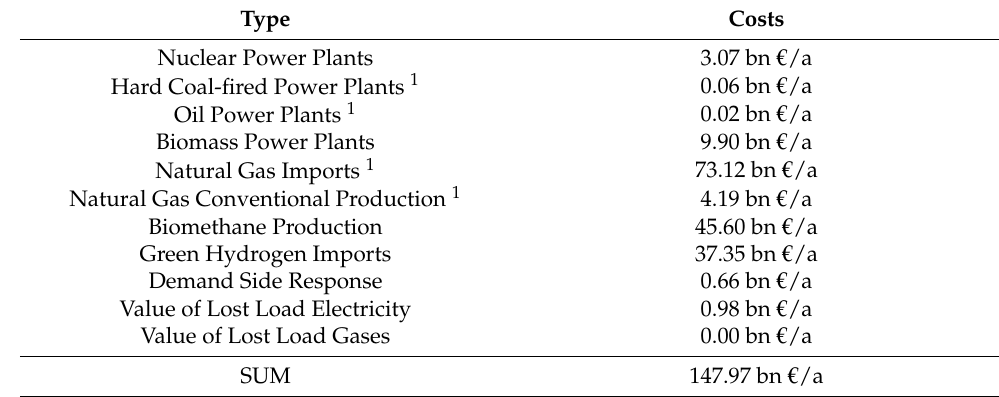
Figure 3. Considered infrastructure models: power plant fleet ( top left ), electric transmission system ( top right ), hydrogen transmission system ( bottom left ), natural gas (methane) transmission system ( bottom right ). Table 7. European dispatch costs (model